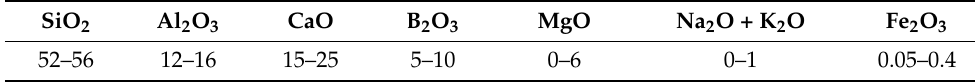
Figure 3. Mixing foam and slurry. Table 2. The chemical composition of the glass fiber (%).